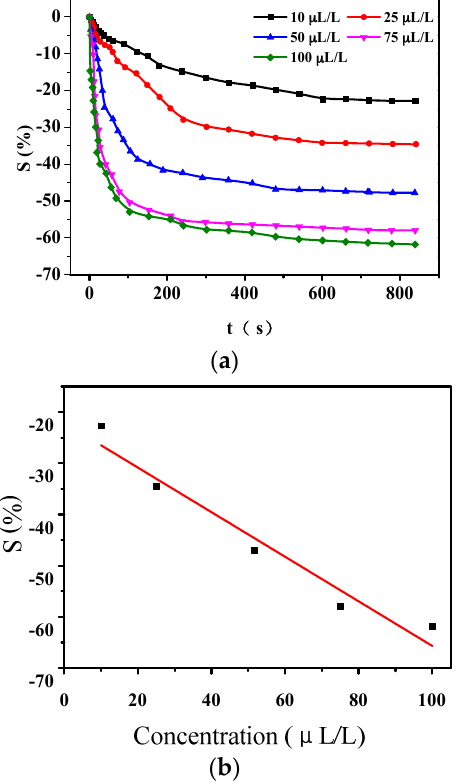
Figure 10. Gas-sensing response of PANI-HCl/SSA sensor to H 2 S of different concentration. ( a ) Response to various concentration of H 2 S; ( b ) Liner dependence between sensitivity and gas concentration.